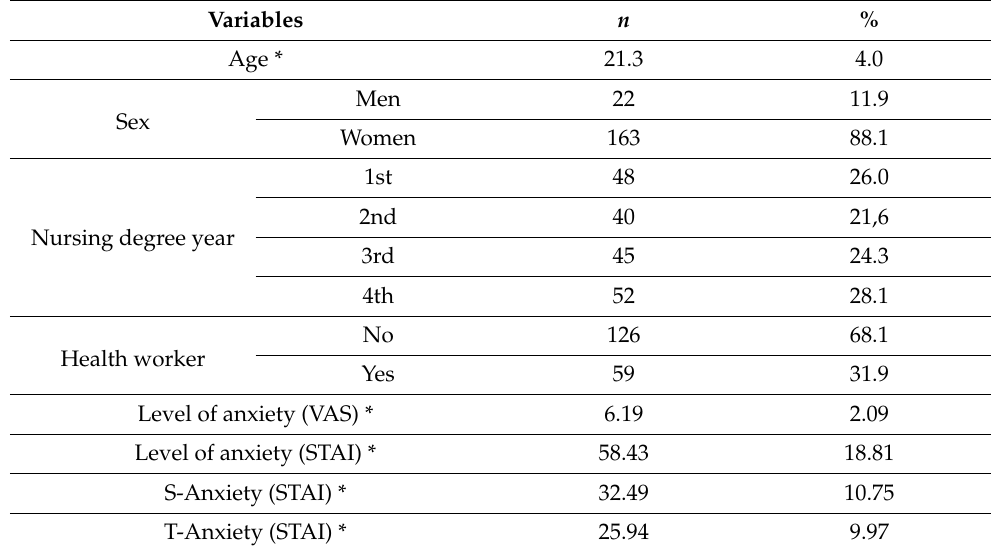
Table 1. Characteristics of the sample: number ( n ) and frequencies (%).